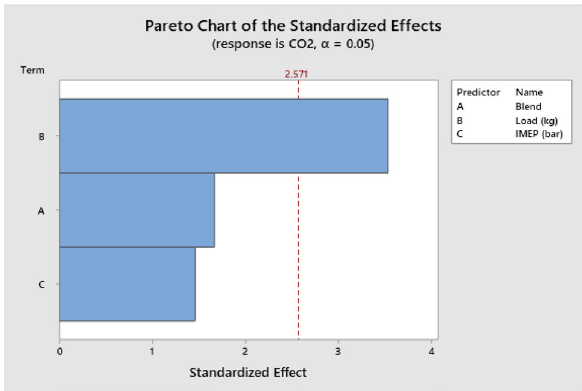
versus blend, load (kg), IMEP (bar) 2